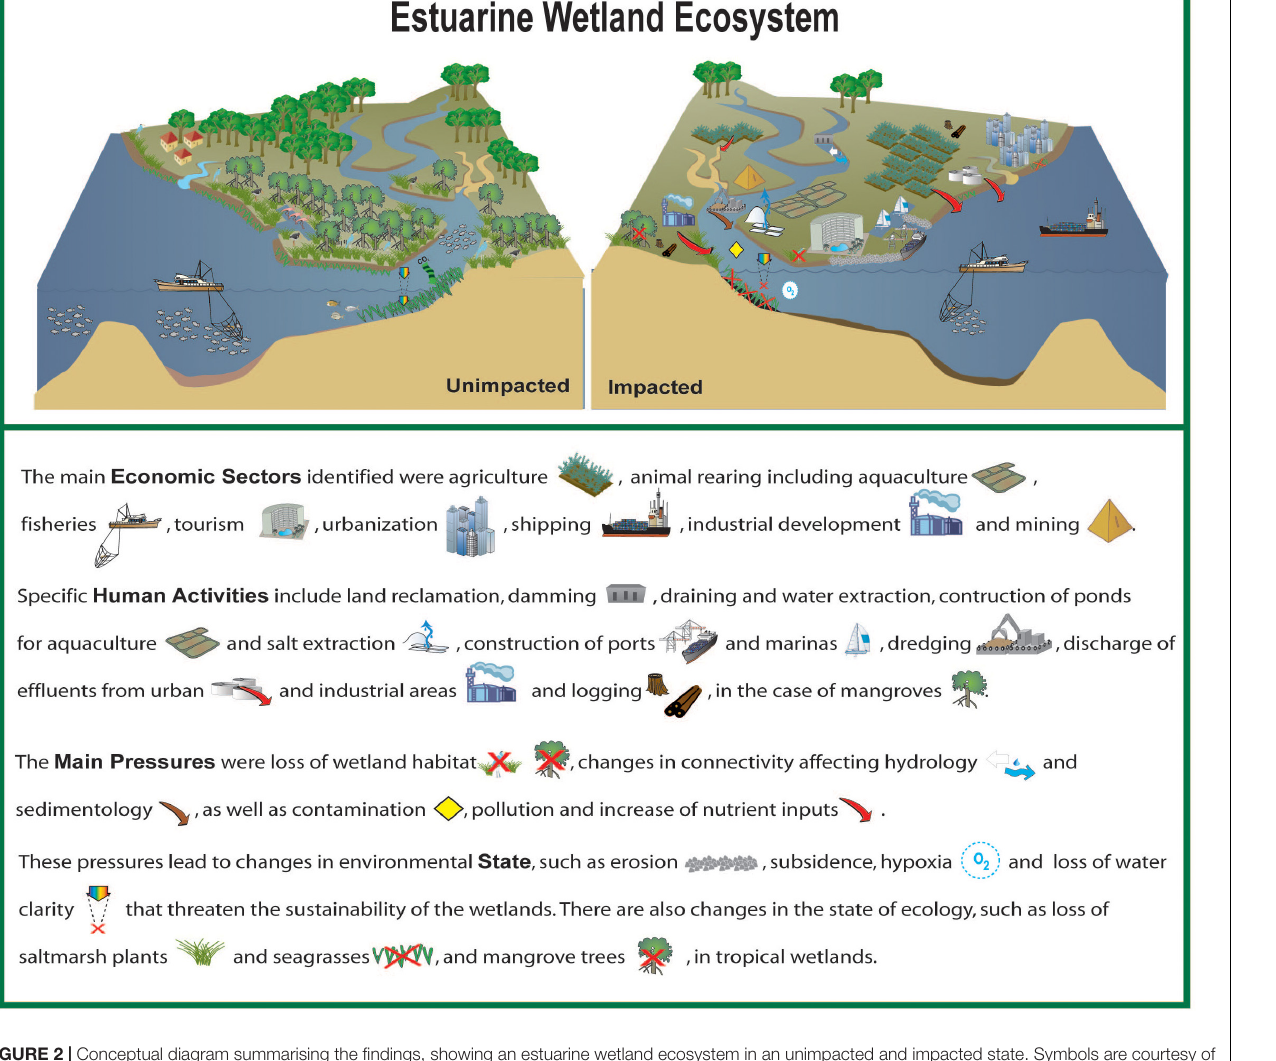
FIGURE 2 | Conceptual diagram summarising the findings, showing an estuarine wetland ecosystem in an unimpacted and impacted state. Symbols are courtesy of the Integration and Application Network, University of Maryland Center for Environmental Science (https://www.umces.edu/ian/search). (Credit: Sonia